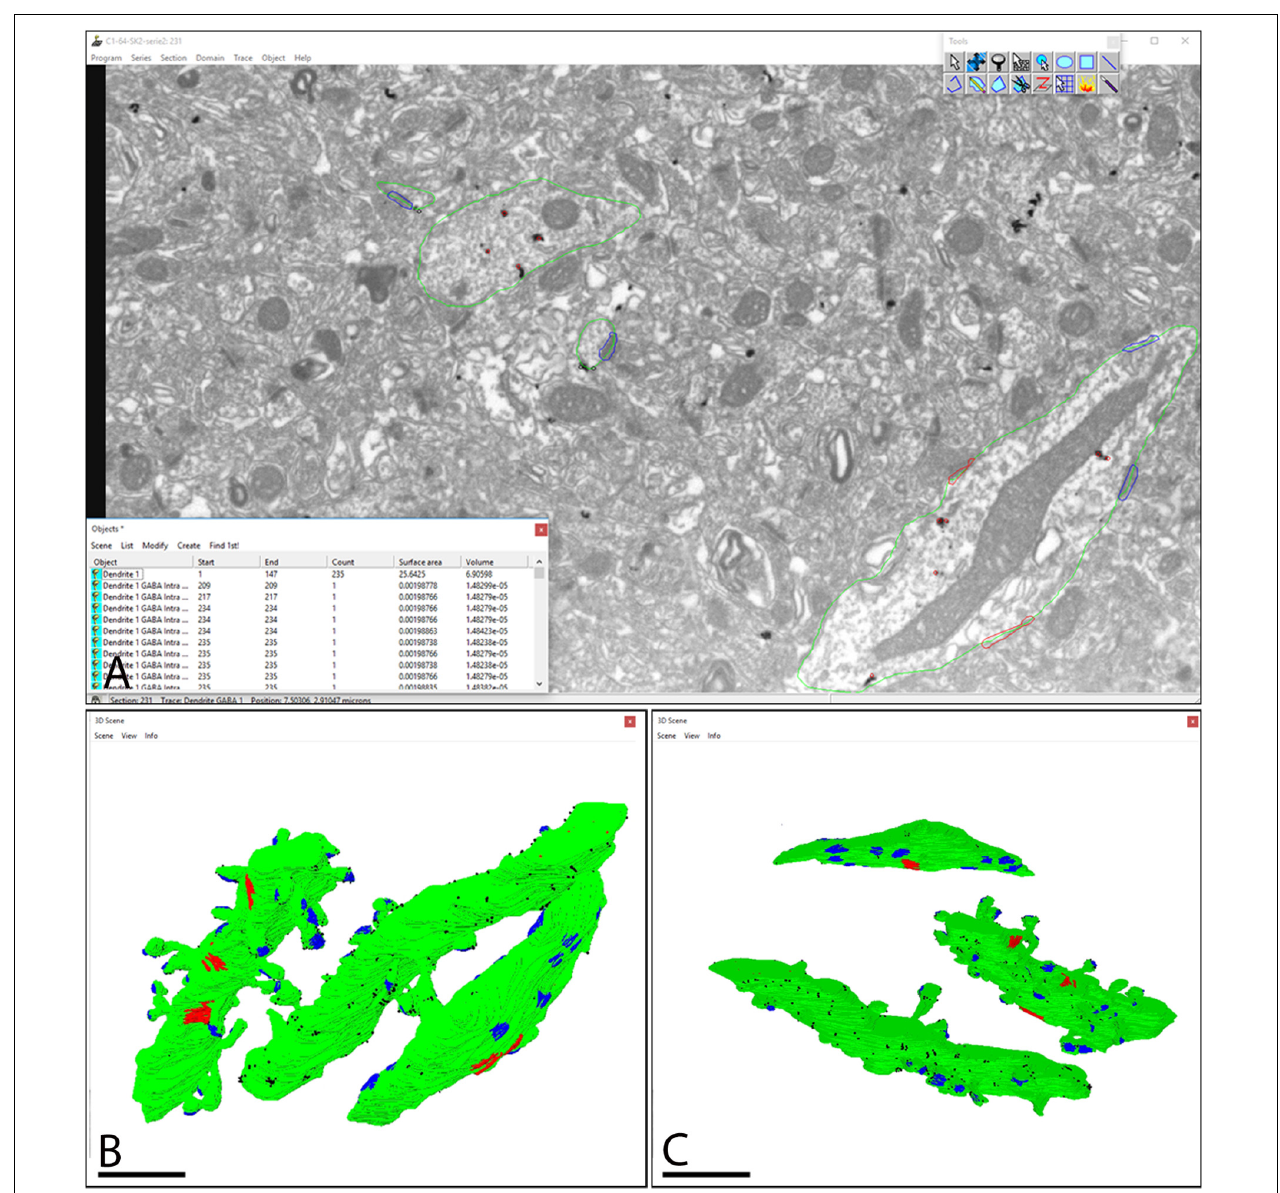
FIGURE 3 | Screenshot of the software tool used for 3D reconstruction and analysis of stacks of serial sections. (A) The Reconstruct software interface allows visualization of the image stacks and permits the identification and 3D reconstruction of all SK2 immunoreactive neuronal elements and a list of all objects outlined to be reconstructed. Green lines outline SK2 immunoreactive dendritic shafts and spines. Immunoparticles on plasma membrane and intracellular sites are outlined in black and red, respectively. (B,C) The structures of interest immunoreactive for SK2 can also be represented in 3D. Two SK2 immunopositive dendrites of pyramidal cells and one of interneuron are represented and visualized in two different angles. Every reconstructed object is color-coded (surface of dendrites in green, SK2 immunoparticles in black, asymmetric synapses in blue, symmetric synapses in red), so they can be individually accessed. Scale bar: (B,C) 1 µ